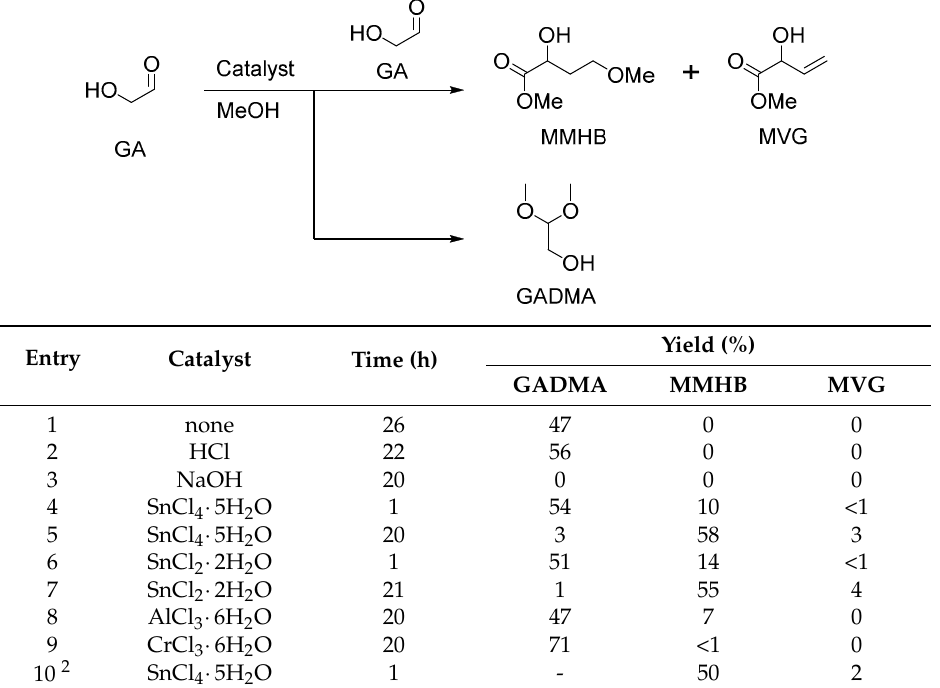
Table 2. Conversion of glycolaldehyde into α -hydroxy acid esters and GADMA in CH 3 OH 1 .